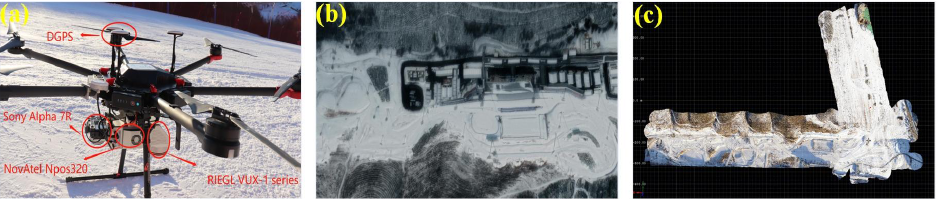
Figure 7. Acquisition system and on-site environment. ( a ) UAV-borne Lidar scanning system; ( b ) the location of the National Biathlon Ski Center for the Beijing Winter Olympics; ( c ) the collected color